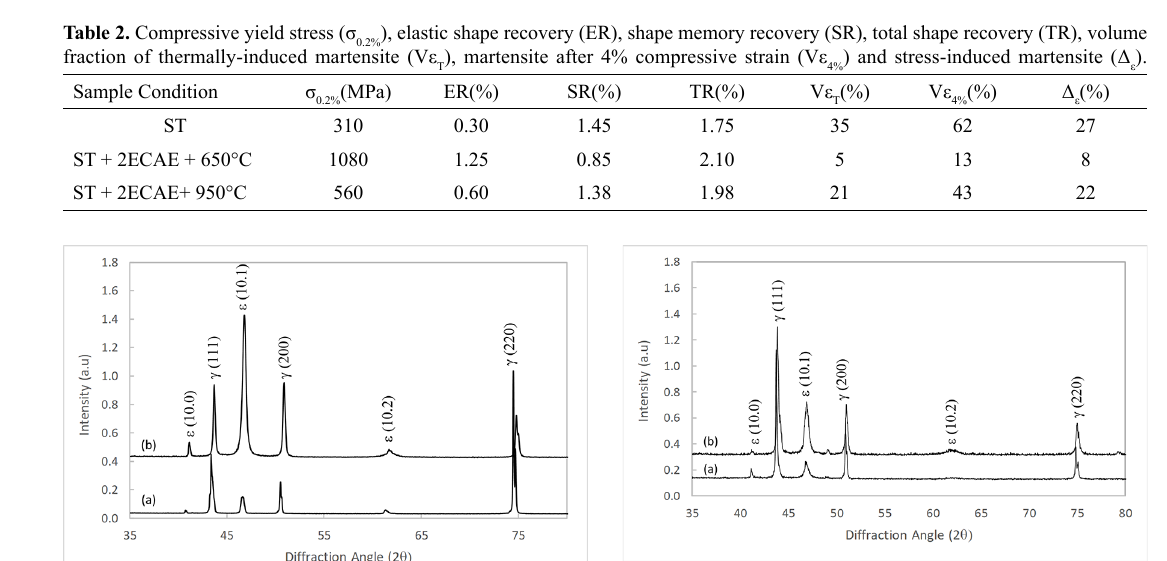
Figure 6. X-Ray Diffraction Patterns: (a) ST, (b) ST + 4 % compressive strain.